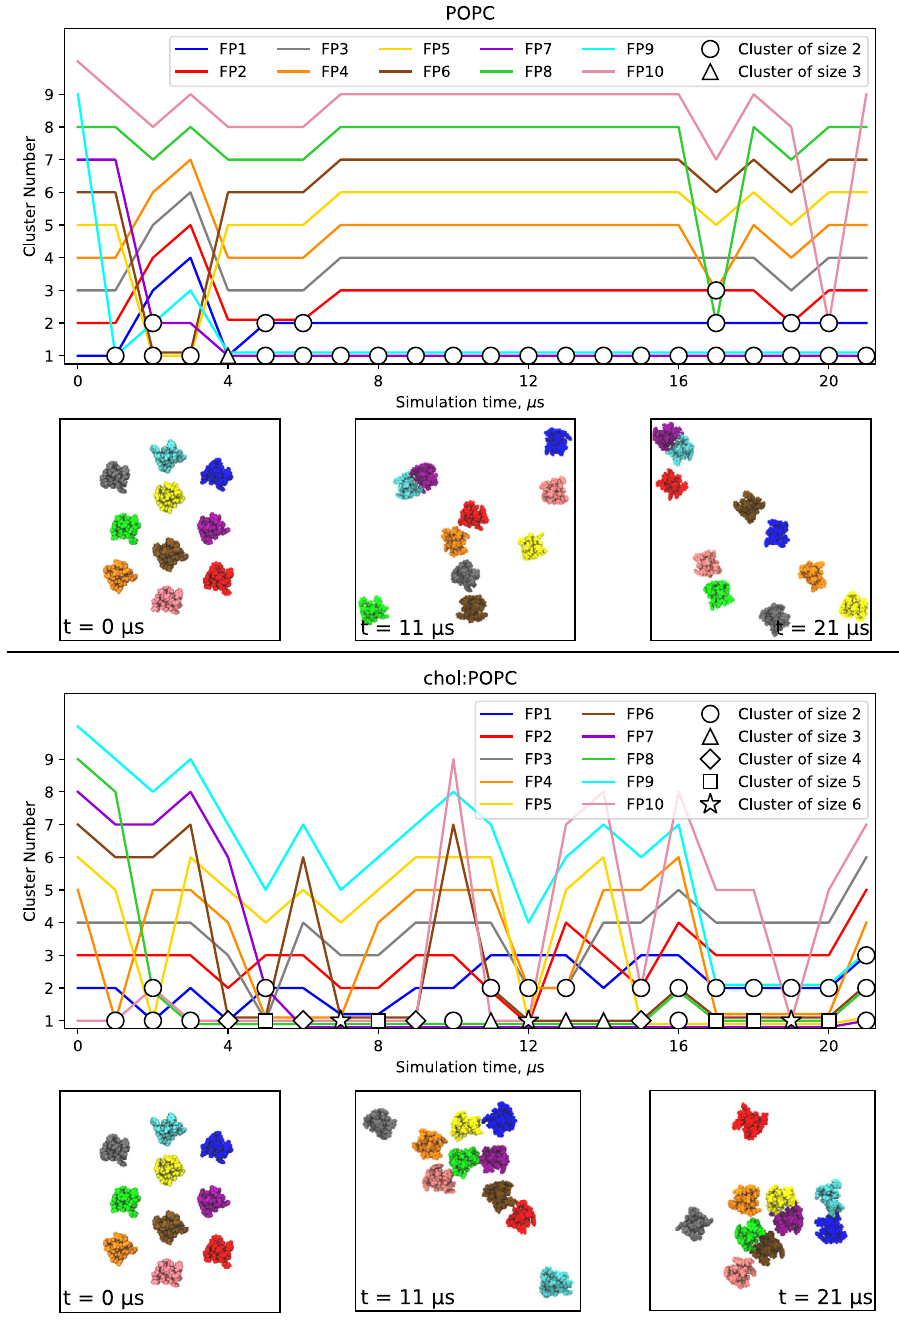
Fig. 4 | Snapshots and clustering of microsecond time-scale MD simulations with 10 FP. Snapshots are shown at times 0, 11 and 21 μ s of the 21 μ s simulation. Plots show the cluster composition at each microsecond, with the symbol